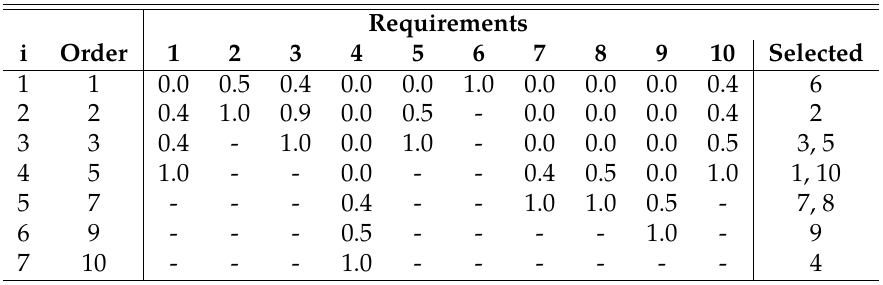
Table 5: Algorithm iterations for requirements prioritization. An − shows the requirements that were selected